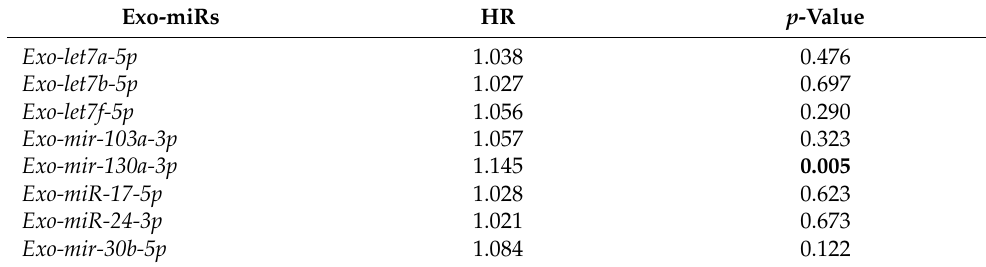
Table 3. Coefficients and relative p -values of the univariate Cox regression model using 8 Exo-miRs on ddPCR data (n = 63). In bold is reported significant p -value (<0.05). Exo-miRs HR p